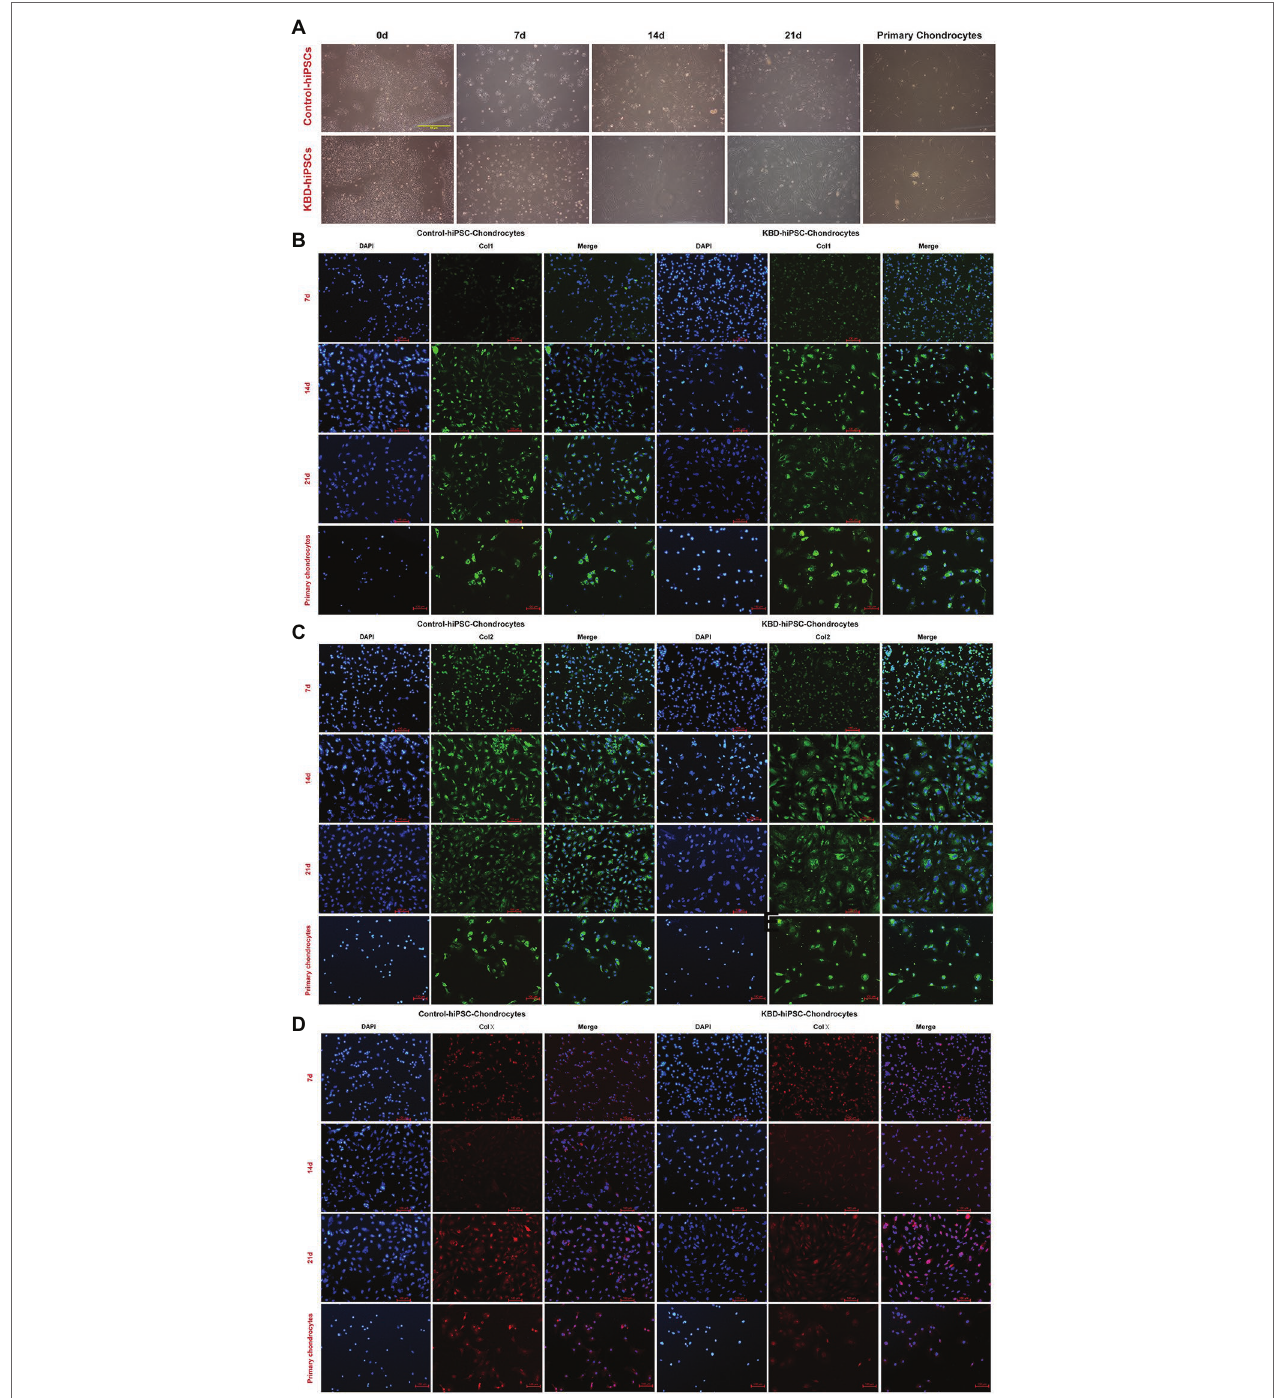
FIGURE 2 | Both the control hiPSCs and the KBD hiPSCs could differentiate to chondrocytes. (A) Cell morphological changes under optical microscope of the hiPSCs during the process of chondrogenesis. (B–D) Immunofluorescence staining of the hiPSCs at days 7, 14, and 21 during chondrogenic differentiation. Both the differentiated control hiPSCs and the KBD hiPSCs could express Col1 (B) , Col2 (C) , and Col10 (D) . hiPSCs, human induced pluripotent stem cells; KBD, Kashin–Beck